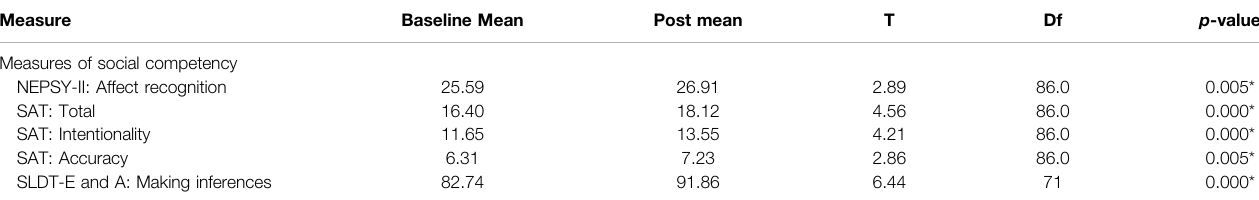
Measure Baseline